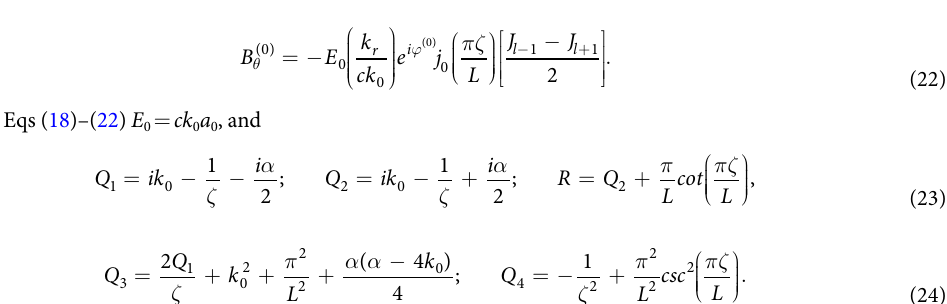
Figure 4. ( a – c ) Surface plots of the axial electric field intensity profile E E / short and tightly-focused analog of the order-2 Bessel beam ( l = 2). These are snapshots taken at t = 10 fs, 10 ps and 1 ns, respectively, during propagation of the pulse in vacuum. ( e – g ) Show the same during propagation in an under-dense plasma, with ambient electron density n 0 = 10 20 cm − 3 . ( d ) and ( h ) show radial variation of the intensity profile at t = 1 ns at the plane defined by z = ct . The remaining parameters used are: L = 1.5 λ 0